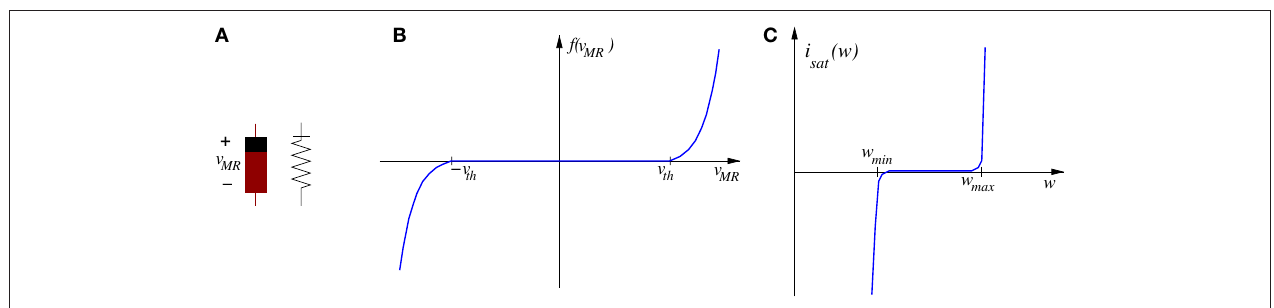
rent leak paths in parallel with the